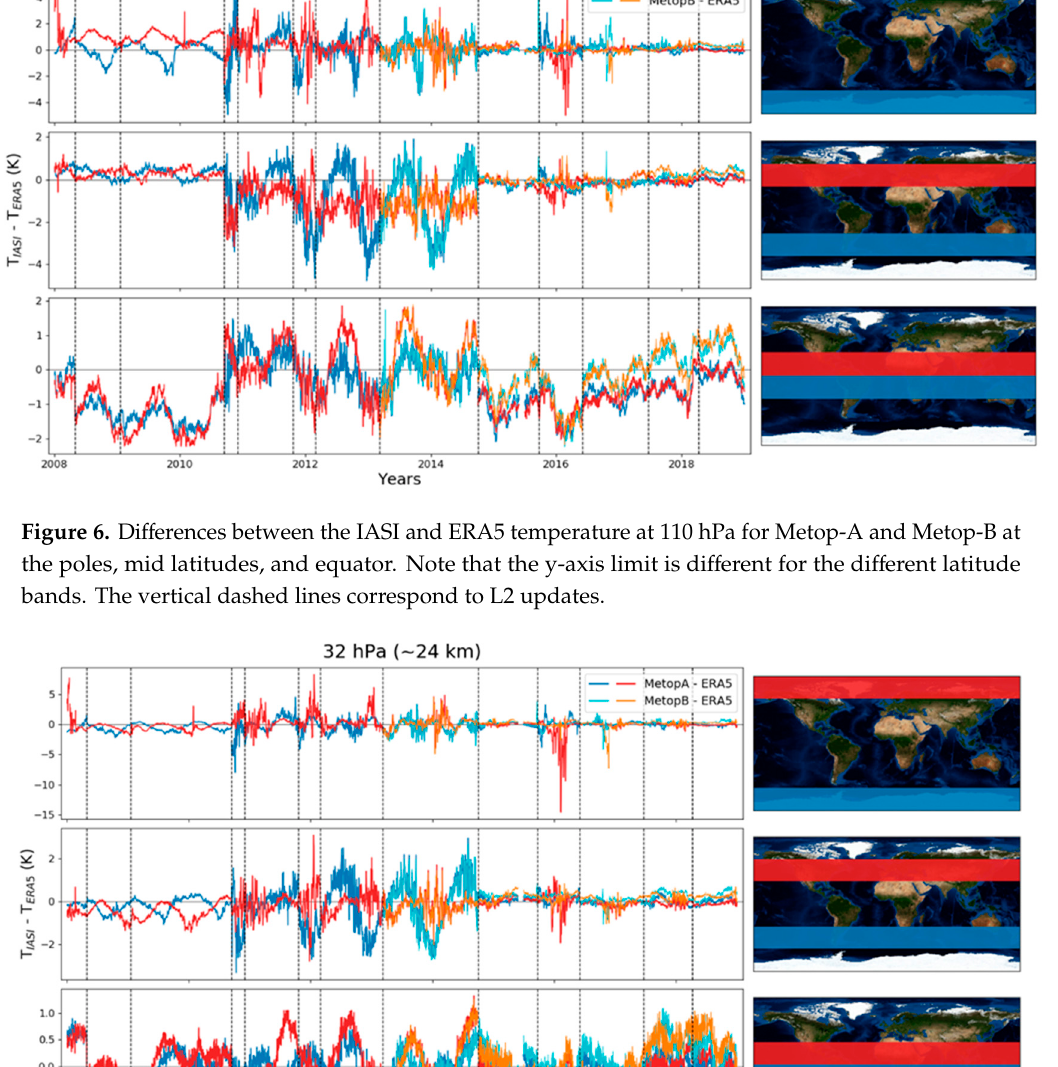
Figure 6. Differences between the IASI and ERA5 temperature at 110 hPa for Metop-A and Metop-B at the poles, mid latitudes, and equator. Note that the y-axis limit is different for the different latitude bands. The vertical dashed lines correspond to L2 updates.